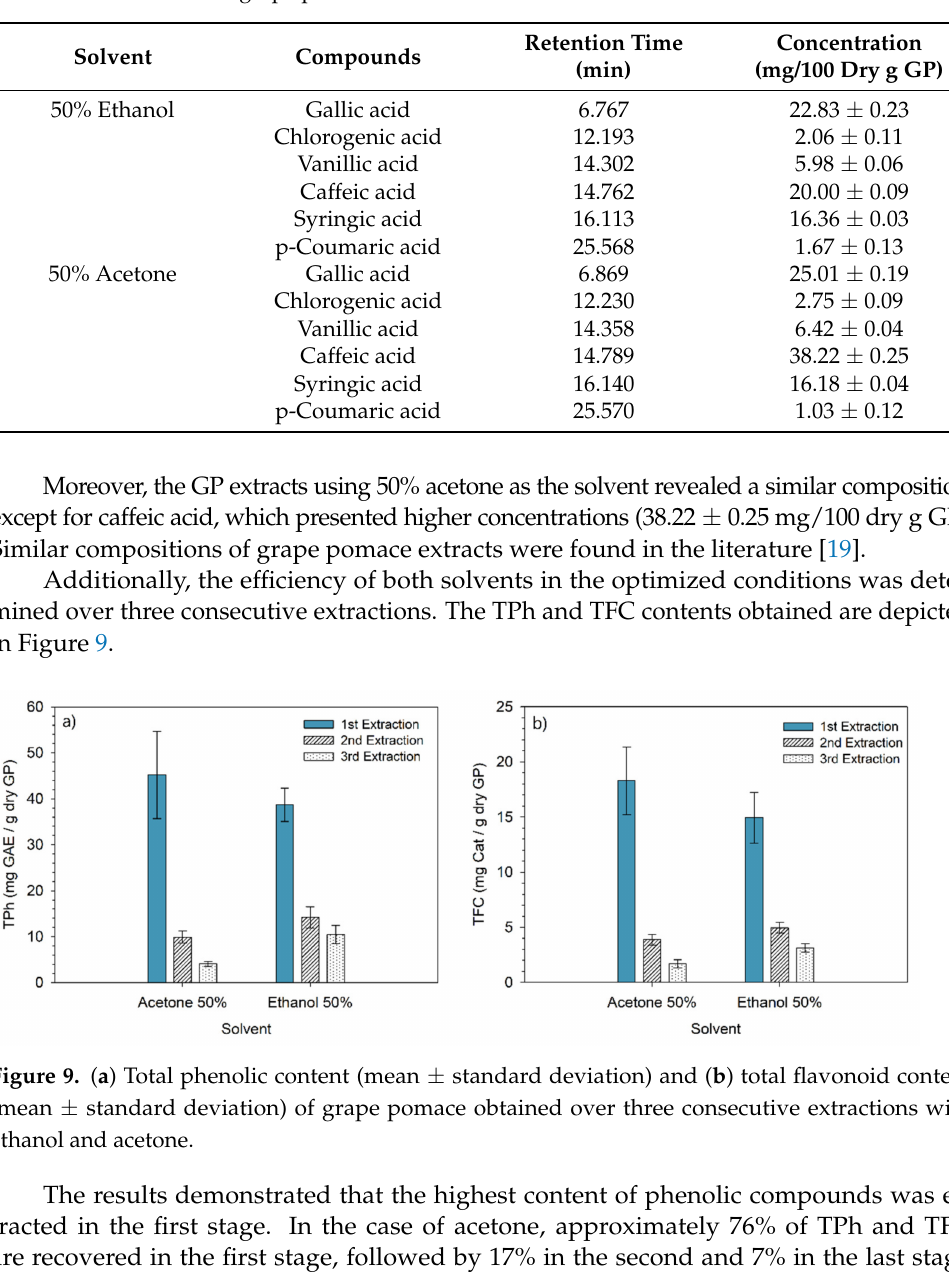
Table 4. Average and standard deviation (n = 3) of the concentrations of the phenolic compounds determined via HPLC in grape pomace extracts.